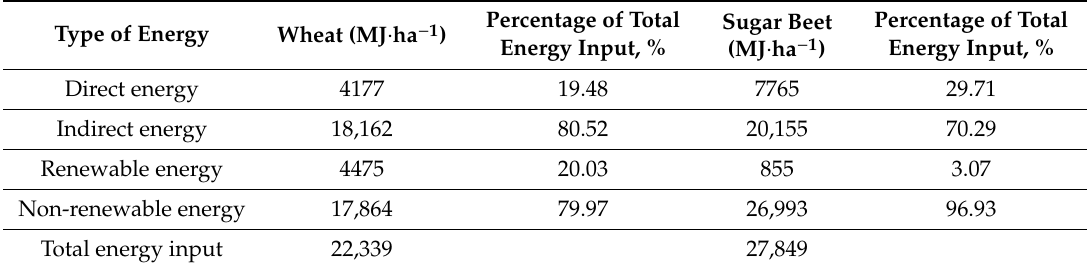
Table 4. Total energy input in the form of direct, indirect, renewable, and non-renewable energy for wheat and sugar beet